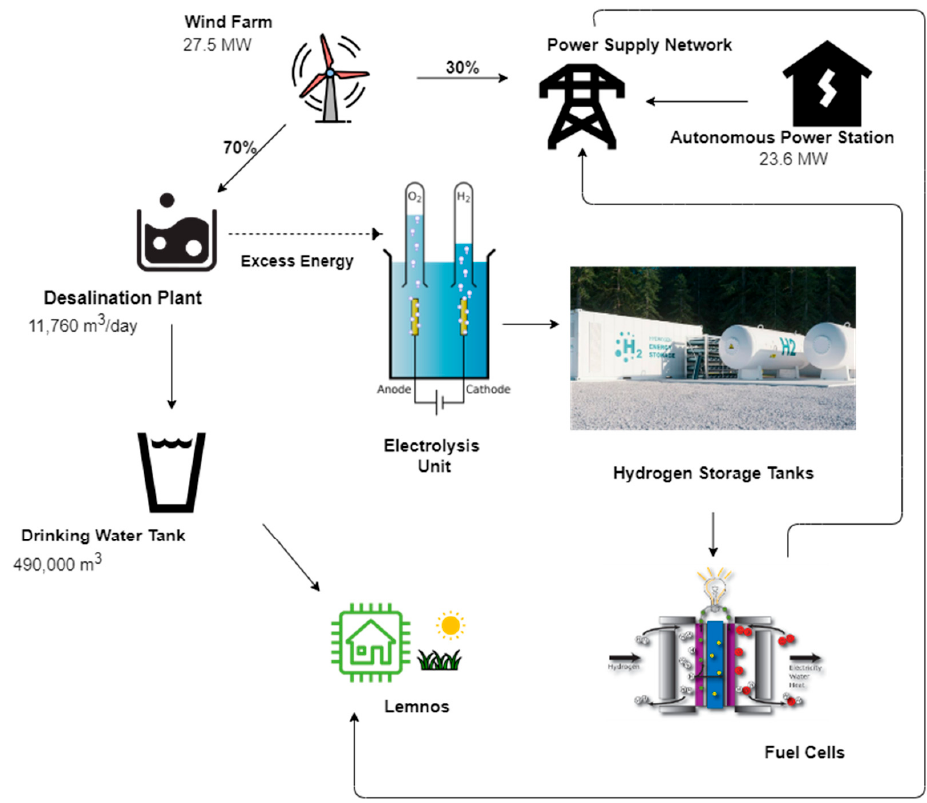
Figure 9. Schematic representation of operating scenario 2.